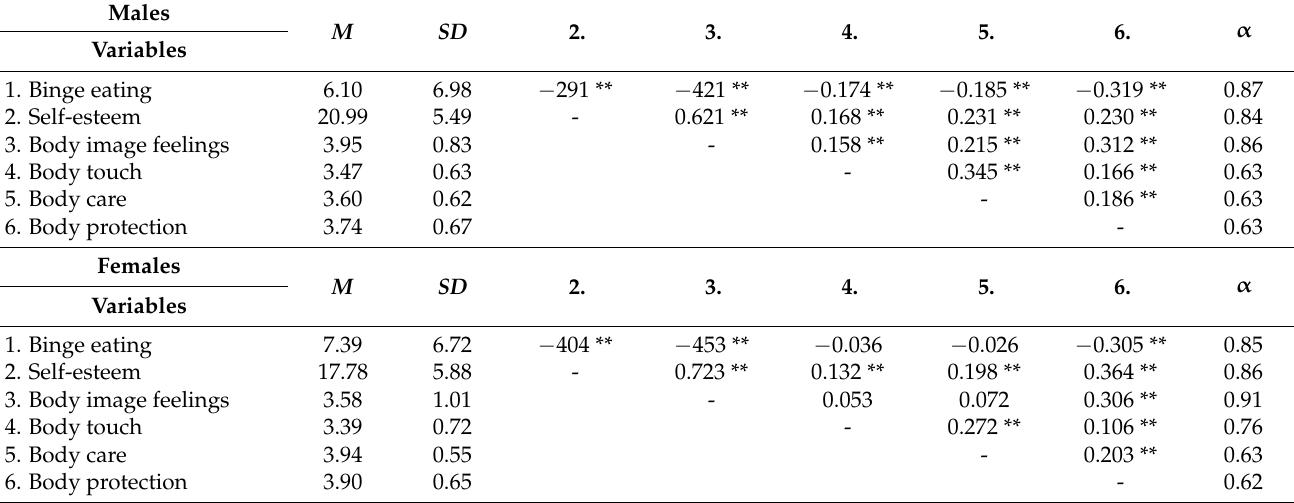
Table 1. Means, standard deviations, and correlation coefficients of study